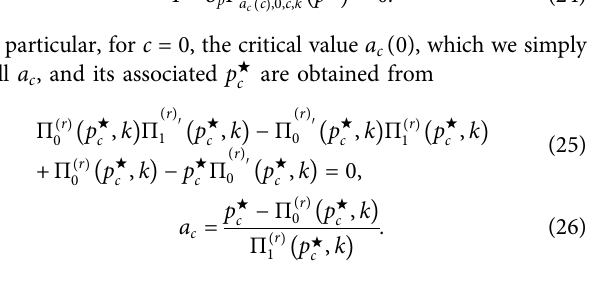
Frontiers in Physics |